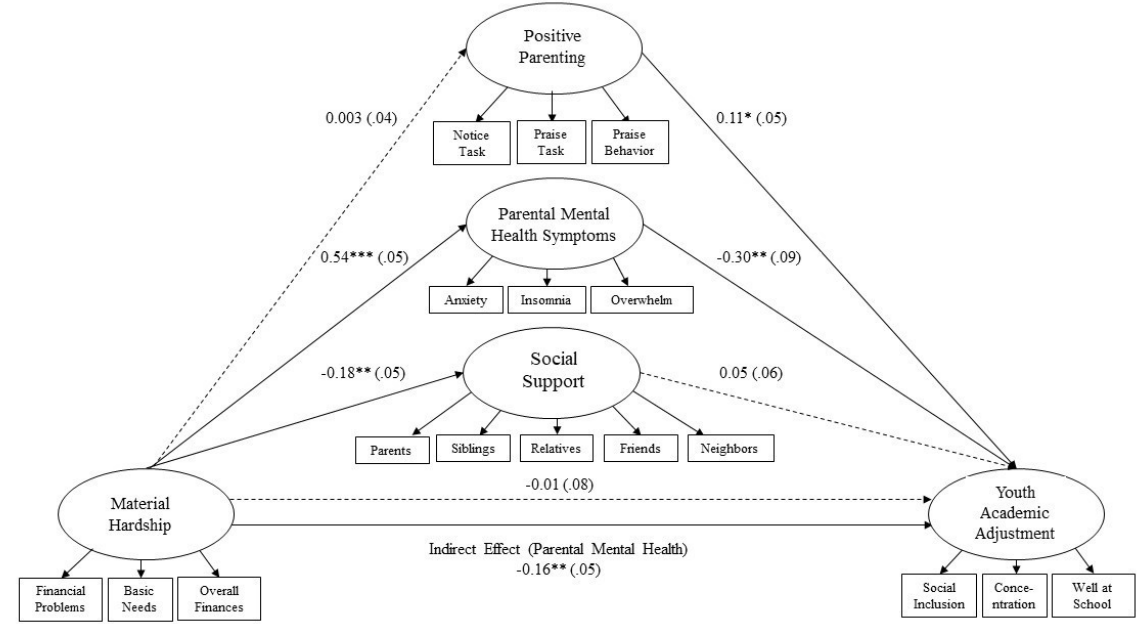
Figure 2. Structural Equation Analytical Model Results. * Correlation is significant at the 0.05 level (2-tailed). ** Correlation is significant at the 0.01 level (2-tailed). *** Correlation is significant at the 0.001 level (2-tailed).